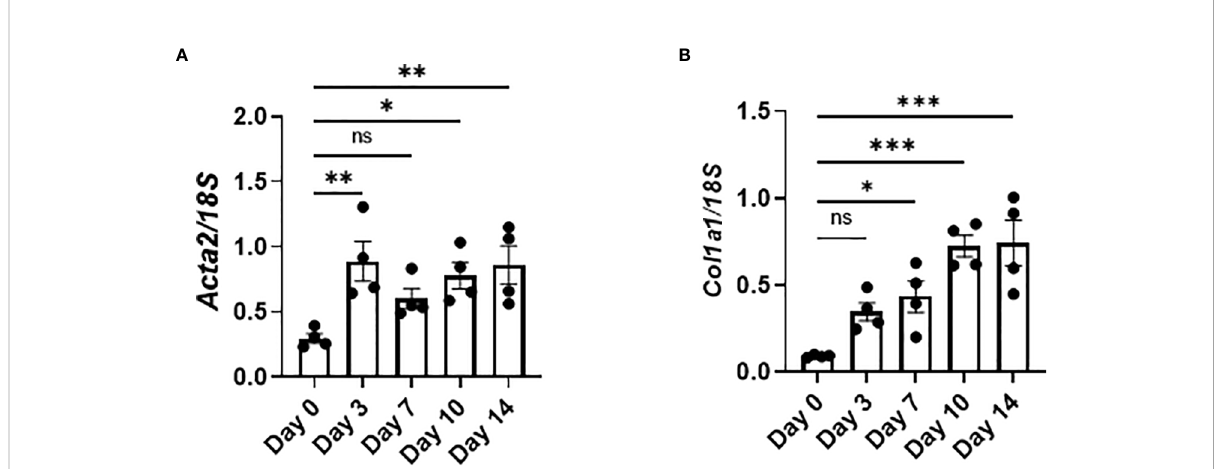
FIGURE 6 Activated fi broblasts produce collagen from the early phase in BLM-ILD. Lungs were obtained before and 3, 7, 10, and 14 days after the BLM instillation and subjected to qRT-PCR. The expression of Col1a1 (A) and Acta2 (B) in the lungs on the indicated days. n = 4 per day. Data are presented as the mean ± SEM. Statistics show p-values from a one-way ANOVA with Dunnett ’ s multiple comparisons test as the post-hoc test comparing values on day 0. ns, not signi fi cant. *p < 0.05; **p < 0.01; ***p <